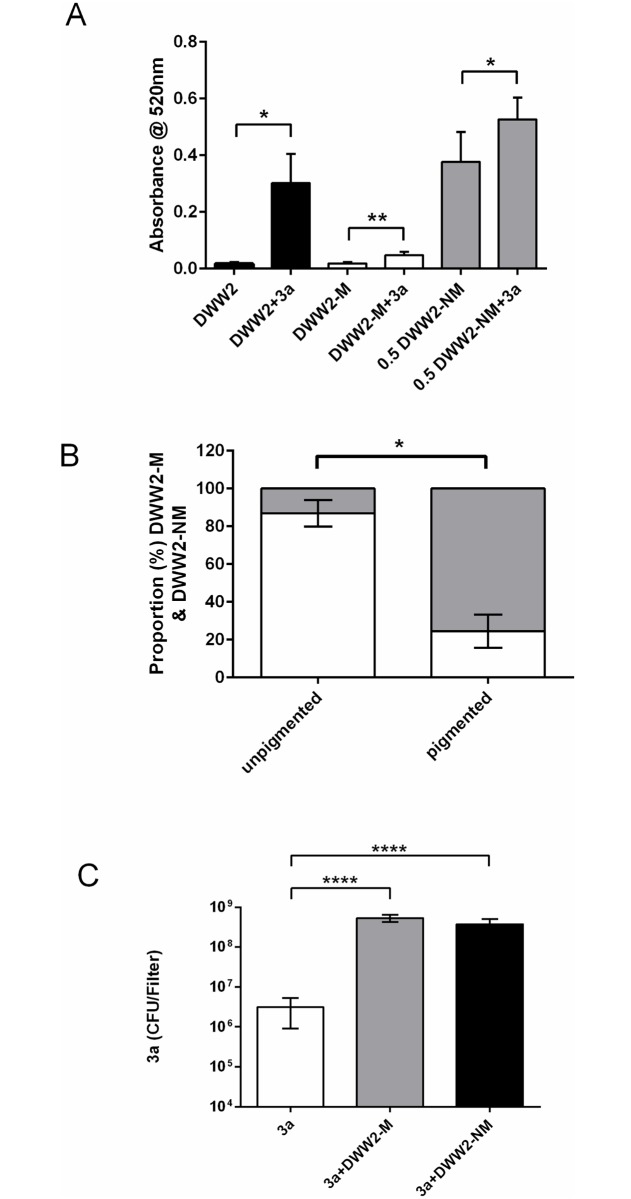
Examples of biofilms at 24 h, 48 h and 72 h.Examples of biofilms at the timepoints examined during these experiments are shown for i) monocultures of DWW2 (Row a), DWW2-M (Row c) and DWW2-NM (Row e), ii) co-cultures of 3a + DWW2 (Row b), 3a + DWW2-M (Row d) and 3a + DWW2-NM (Row f).